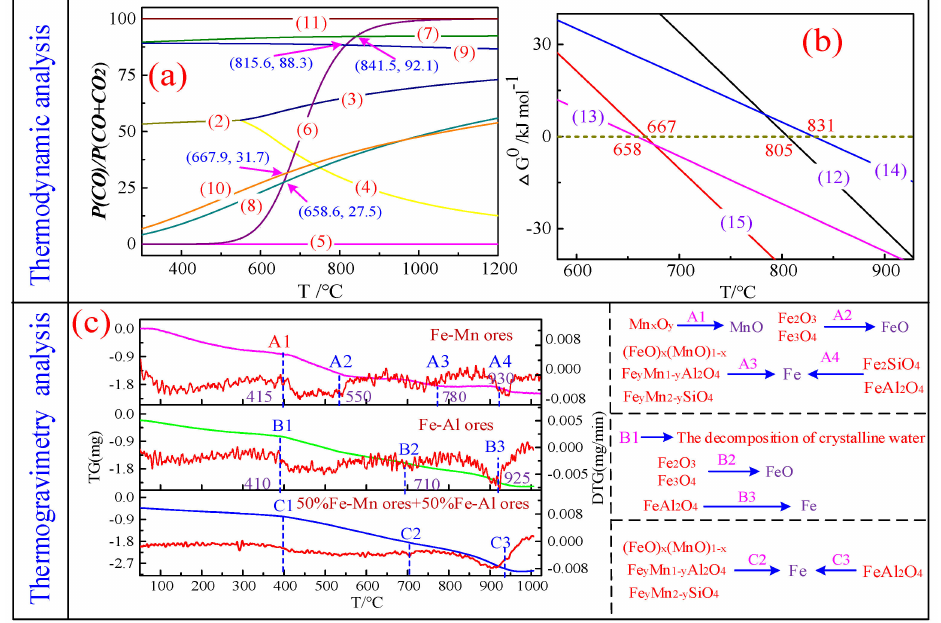
Figure 3. ( a ) Gas–equilibrium diagram of Mn-Fe-C-O system; ( b ) ∆ G 0 -T of FeAl 2 O 4 and Fe 2 SiO 4 ; ( c ) TG/DTG of the Fe-Mn ores and Fe-Al ores from ambient temperature to 1100 ◦ C at a heating rate of 10 ◦ C/min in a pure Ar